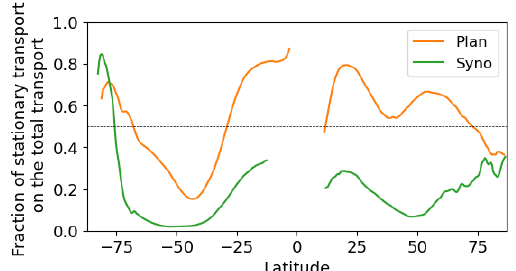
Figure 4. The fraction of the quasi-stationary part of the transport by planetary and synoptic waves as a function of latitude in ERA5.